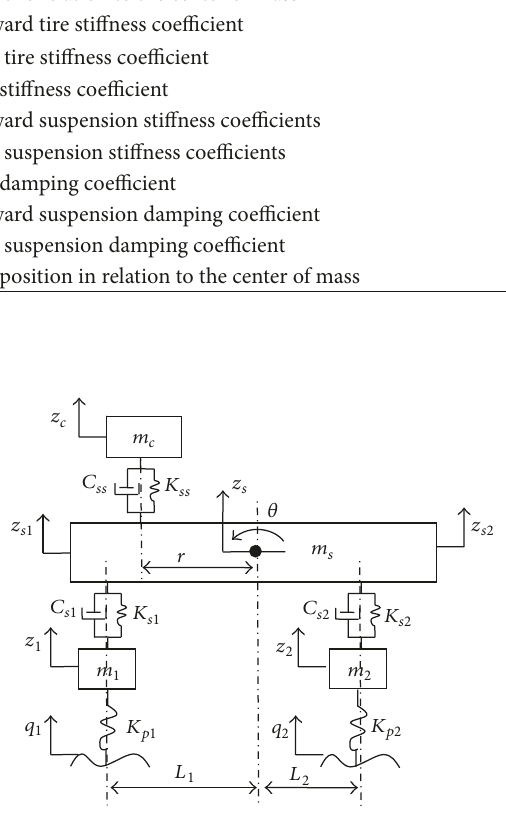
Figure 13: A five-degree-of-freedom vibration model for a vehicle with passive suspension adopted from